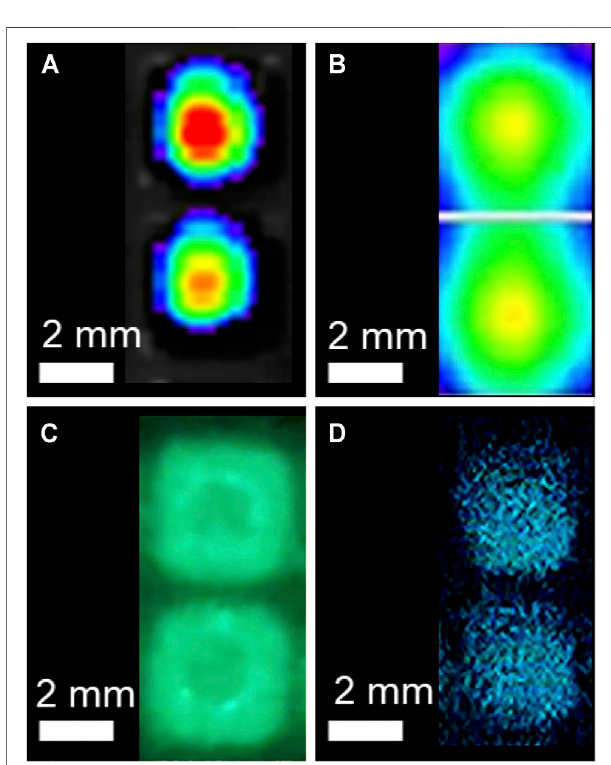
FIGURE 4 | Signal resolution testing of the CCD, PMT, image intensi fi er, and CMOS detection systems. The (A) CCD, (C) image intensi fi er, and (D) CMOS systems all successfully resolved individual signals separated by 0.87 mm following plating of continuously bioluminescent cells in the 384-well plate format. The (A) CCD and (B) PMT images are pseudocolor imageswithwarmercolorsrepresentingrelativelyincreased